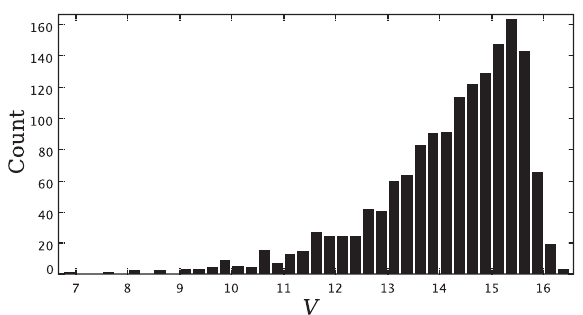
Fig. 2. Distribution of the catalog stars in apparent magnitudes.